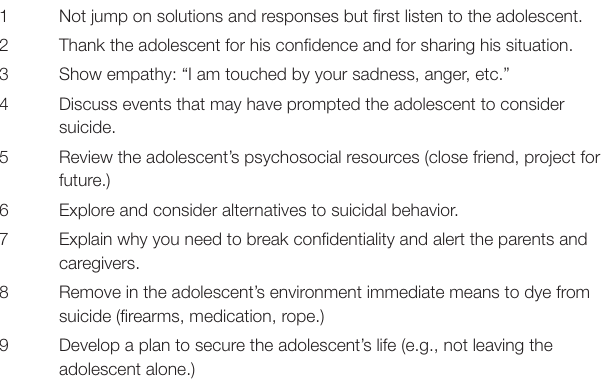
TABLE 3 | Addressing situation with high risk of suicide.